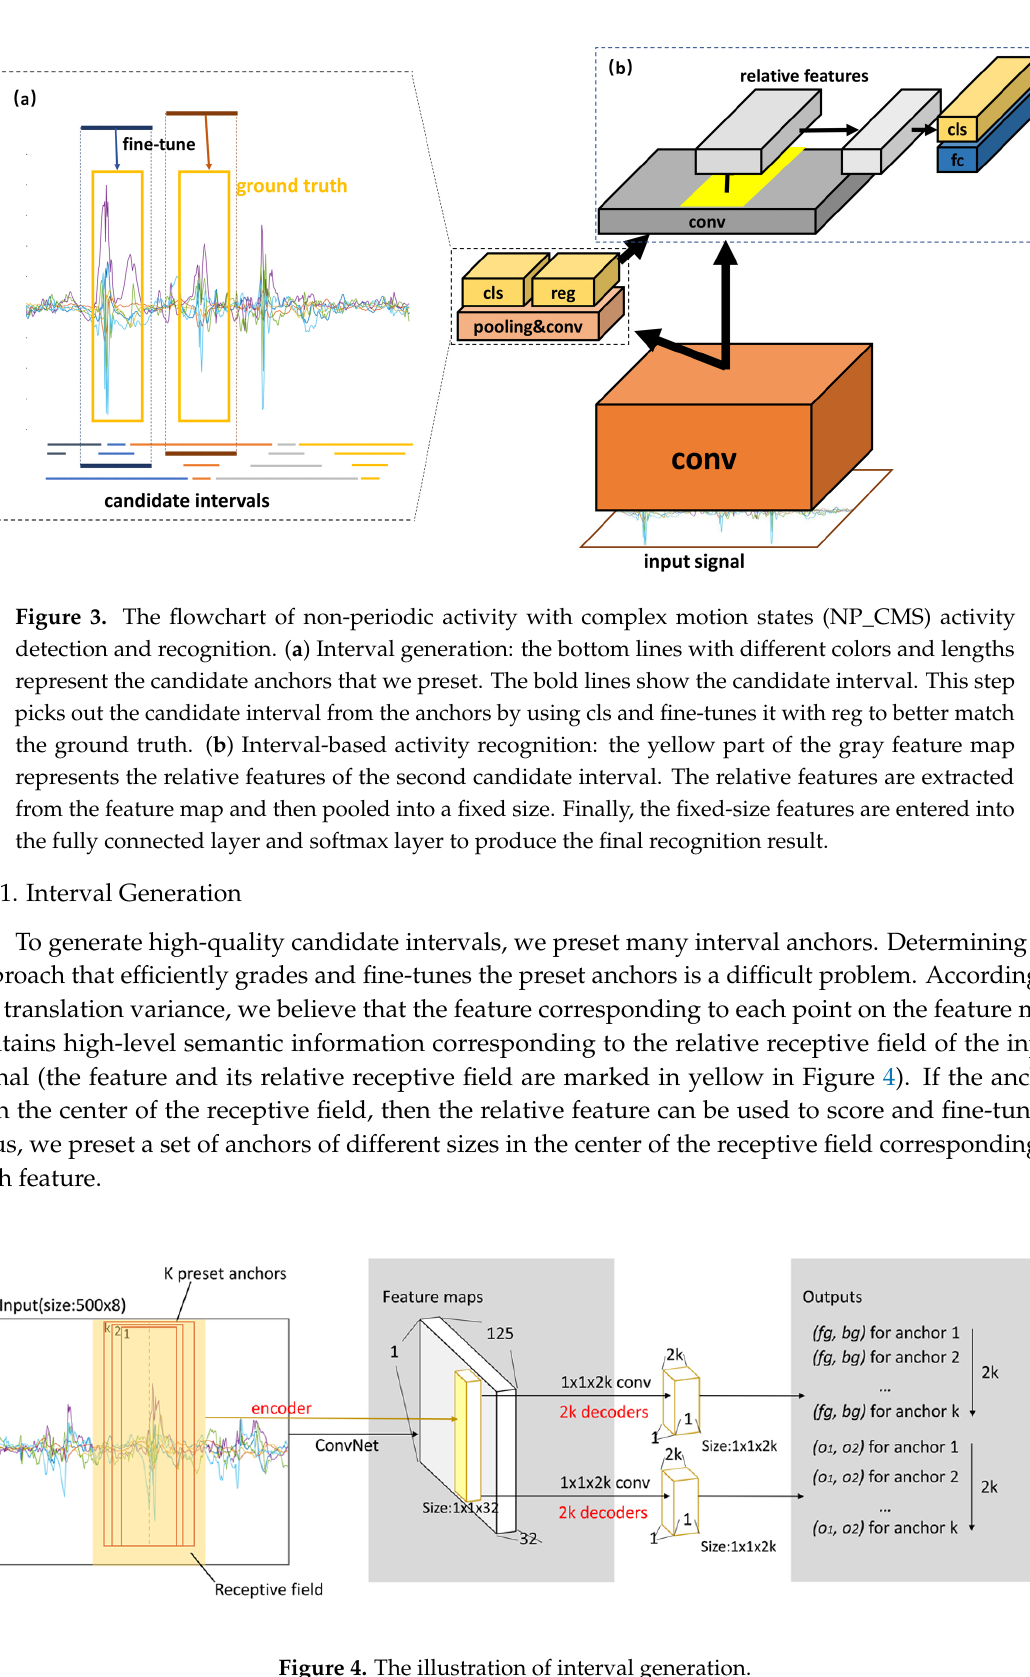
Figure 4. The illustration of interval